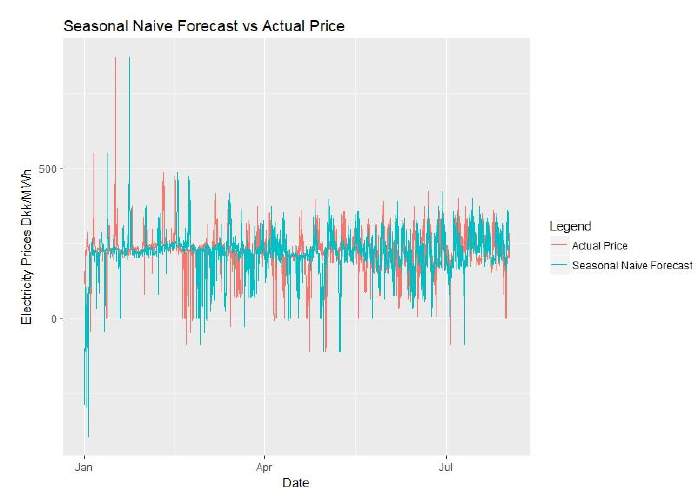
Figure 22. Seasonal Naïve forecast vs. Actual price. Energies 2019 , 12 , x FOR PEER REVIEW